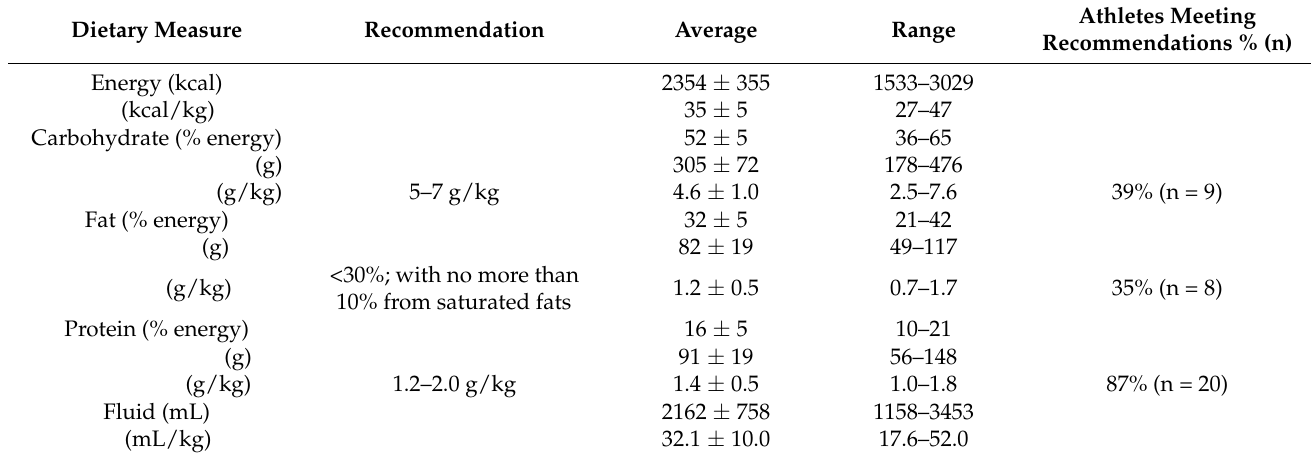
Figure 1. Means ± SD, n = 23. Total daily energy expenditure (TDEE) compared to energy intake (EI) for team over a 7-day period of game, practice, and rest days. The absolute amounts and proportions of each macronutrient consumed/day over the 7-day period was 305 g and 52% from CHO, 82 g and 32% from fat, and 91 g and 16% from protein (Table 1). Fluid intake averaged 2162 mL/day. Table 1. Energy, macronutrient, and fluid intakes of varsity female ice hockey players.